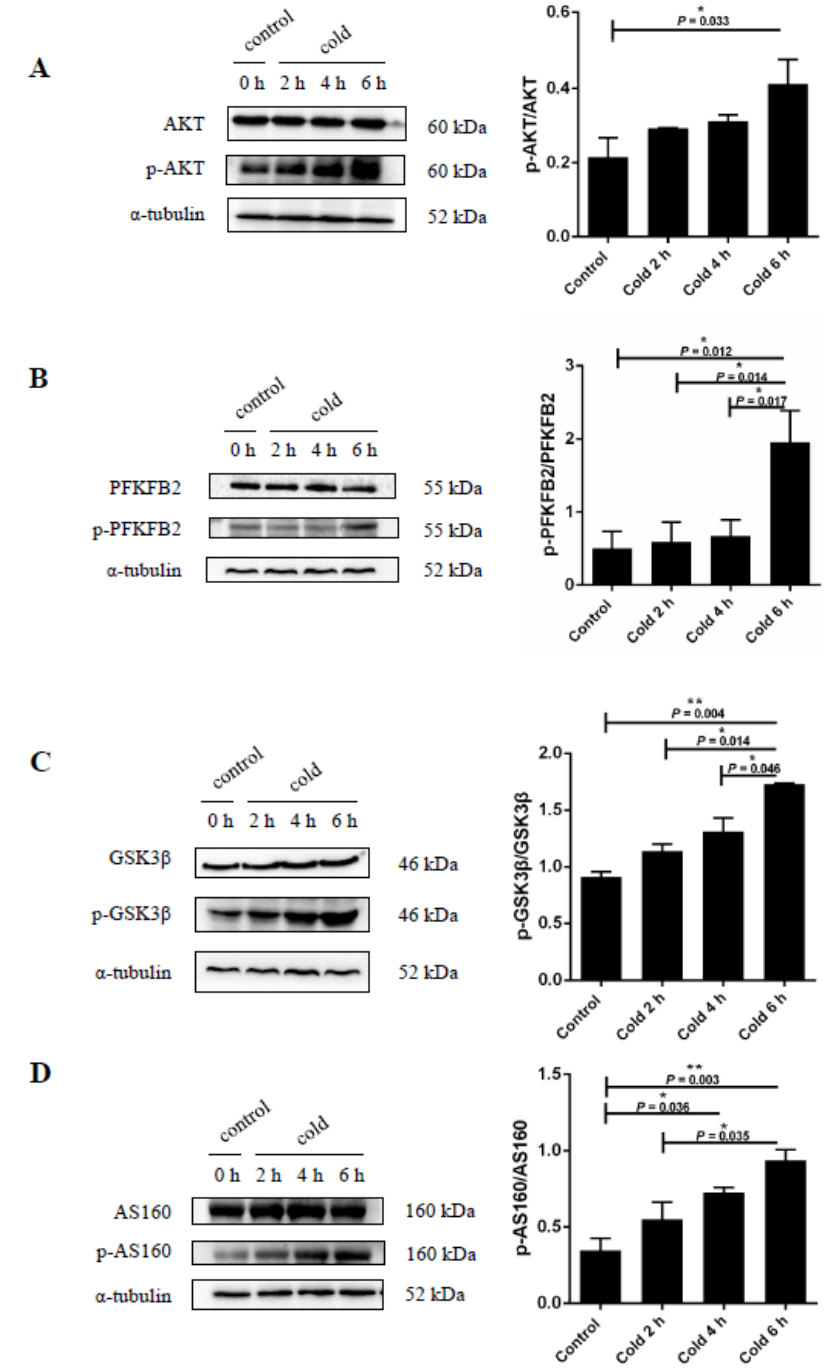
Figure 5. Effect of acute cold stress on glucose metabolism in the liver. ( A ) Protein kinase B (AKT) protein levels and phosphorylation state in the liver; ( B ) 6-phosphofructo-2-kinase/fructose-2,6-biphosphatase 2 (PFKFB2) protein levels and phosphorylation state in the liver; ( C ) glycogen synthase kinase-3 β (GSK3 β ) protein levels and phosphorylation state in the liver; ( D ) 160 kDa AKT substrate (AS160) protein levels and phosphorylation state in the liver. The data are presented as mean ± SEM ( n = 8). Statistically significant differences are indicated, * p < 0.05 and ** p < 0.01.